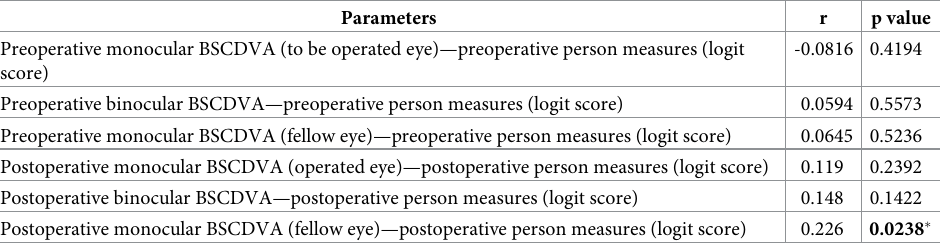
Table 3. Correlations of BSCDVA with person measures (logit